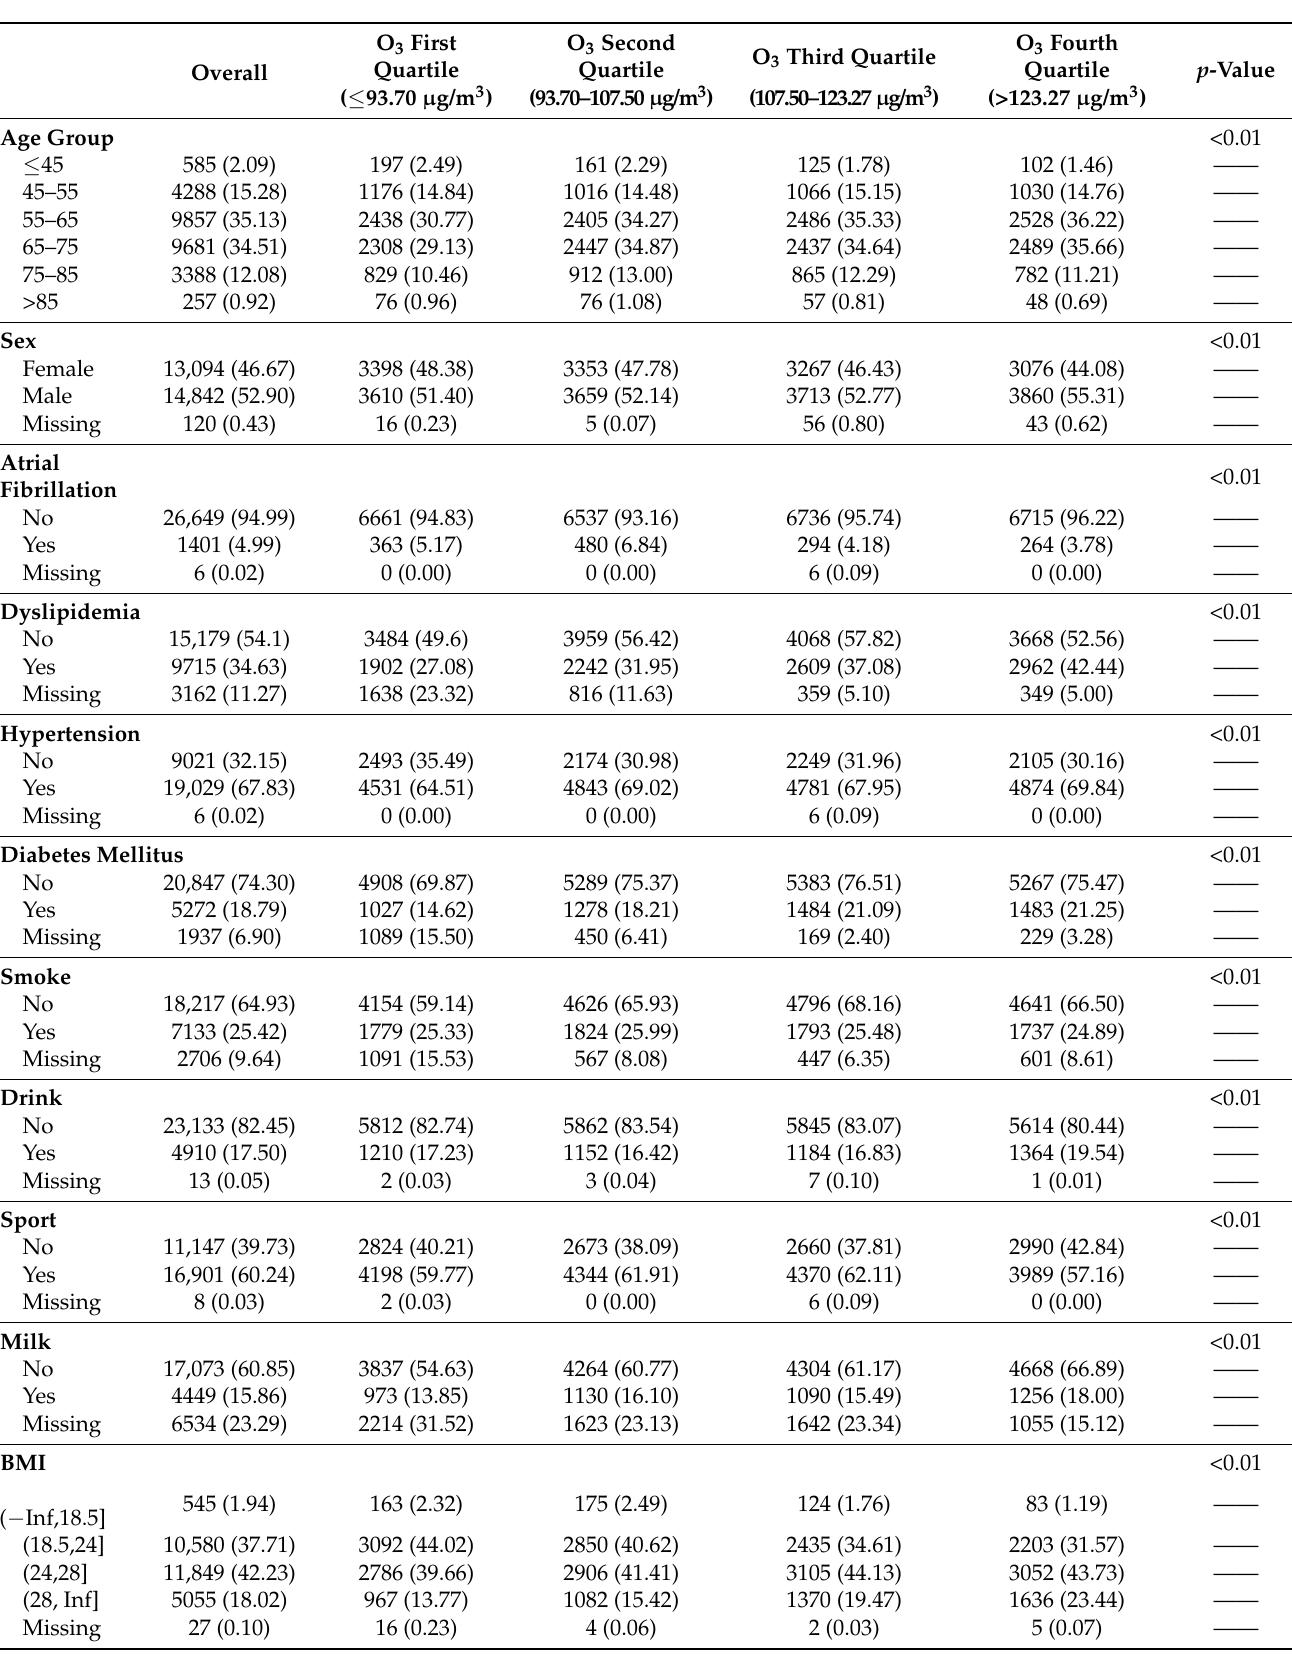
Table 1. Descriptive characteristics of the study participants at baseline by peak-season O 3 concentra- tion